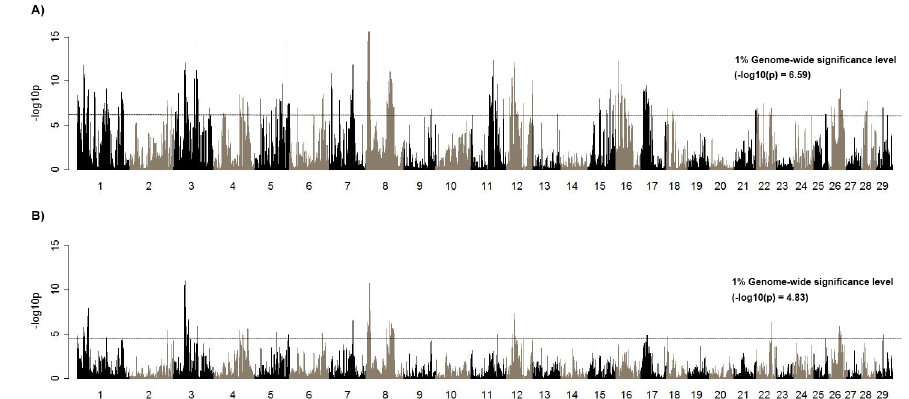
Fig 5. Association between DPR and the most frequent haplotype using additive (A) and recessive model (B). Each bar demonstrates the association of DPR and haplotype that is defined by the 50-SNP window. Association of DPR and the most frequent haplotype (A) or homozygous status of the most frequent haplotype (B) represents an additive or recessive effect. Genome-wide significance level is shown on each